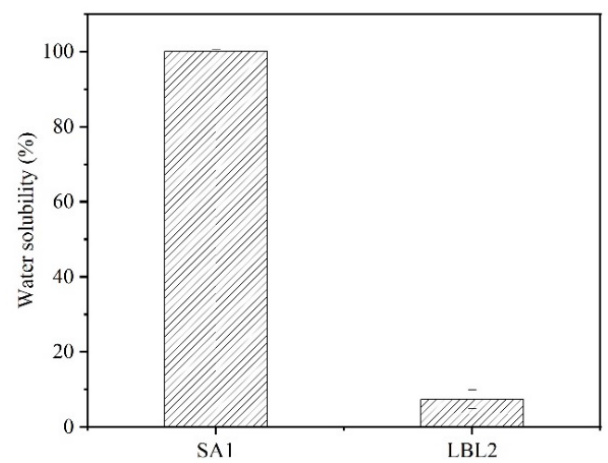
Figure 7. Water solubility of pure sodium alginate (SA) and LBL2 films.